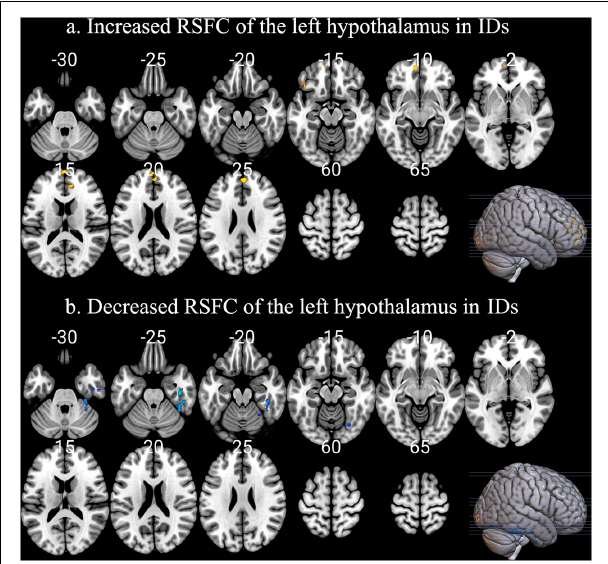
FIGURE 1 | The abnormal RSFC patterns of left hypothalamus in IDs. (a) Compared with HC, ID had significantly increased RSFC between the left hypothalamic and a series of brain regions, including the bilateral medial prefrontal cortex (mPFC) and left pallidum. (b) The right inferior temporal cortex showed reduced RSFC with the left